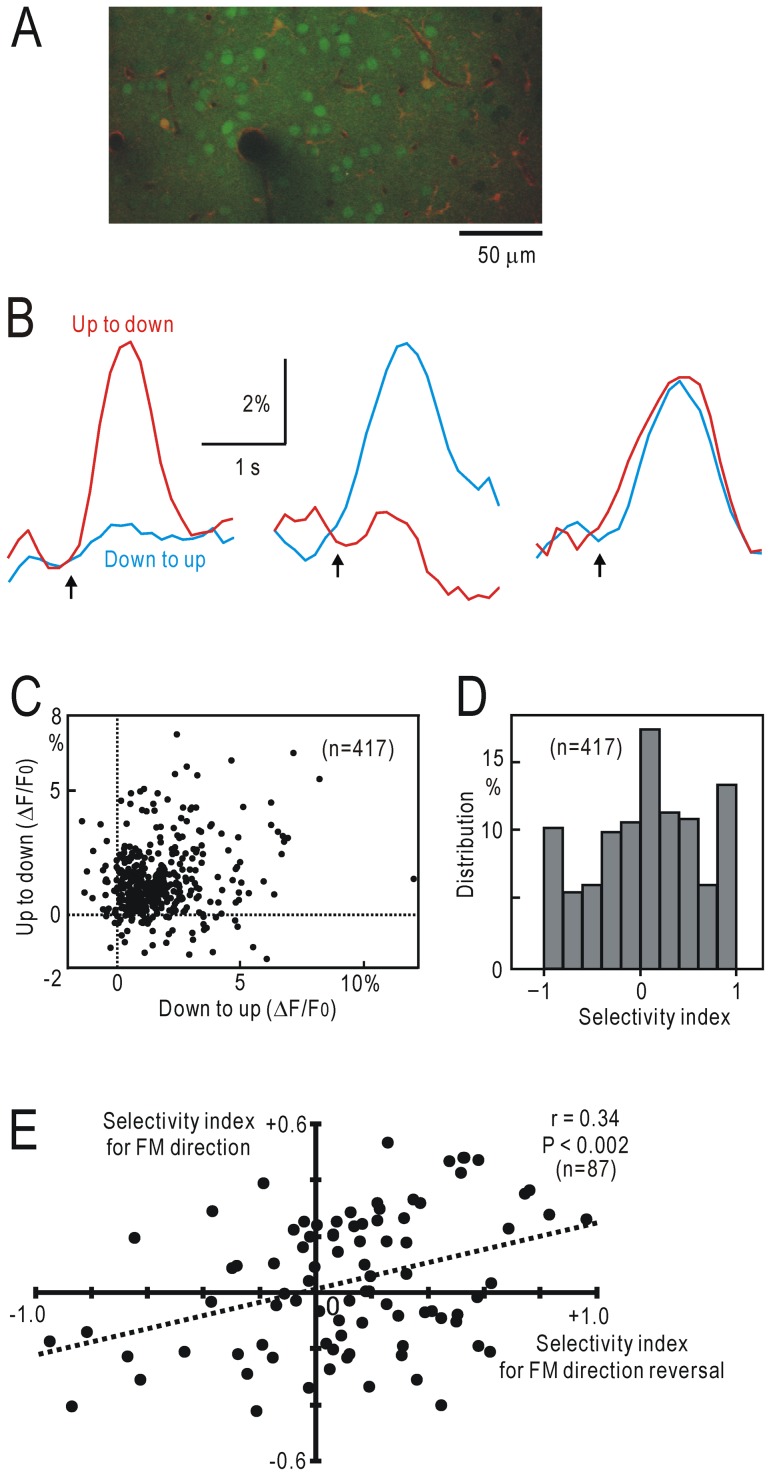
Calcium imaging of UF neurons.(A) Two photon image of cell bodies in UF. Calcium signals were obtained from green neuronal cell bodies stained with fura-2 but not SR101. (B) Neuronal responses selective to FM direction reversal from upward to downward (left), or downward to upward (middle). Right traces were recorded in a neuron responding to FM direction reversal with no apparent preference. Decreases in ΔF/F0 (or calcium increases) were plotted for the upward direction. (C) Relationship between the response amplitudes to FM direction reversal from upward to downward, and from downward to upward in 417 neurons. (D) Selectivity index based on the response amplitudes shown in (C). (E) Relationship between the selectivity index for FM direction reversal and that for FM direction in 87 neurons.